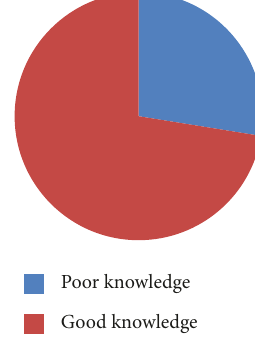
Figure 1: Total distribution of respondents according to their knowledge level on COVID-19 in Dessie town, Ethiopia,